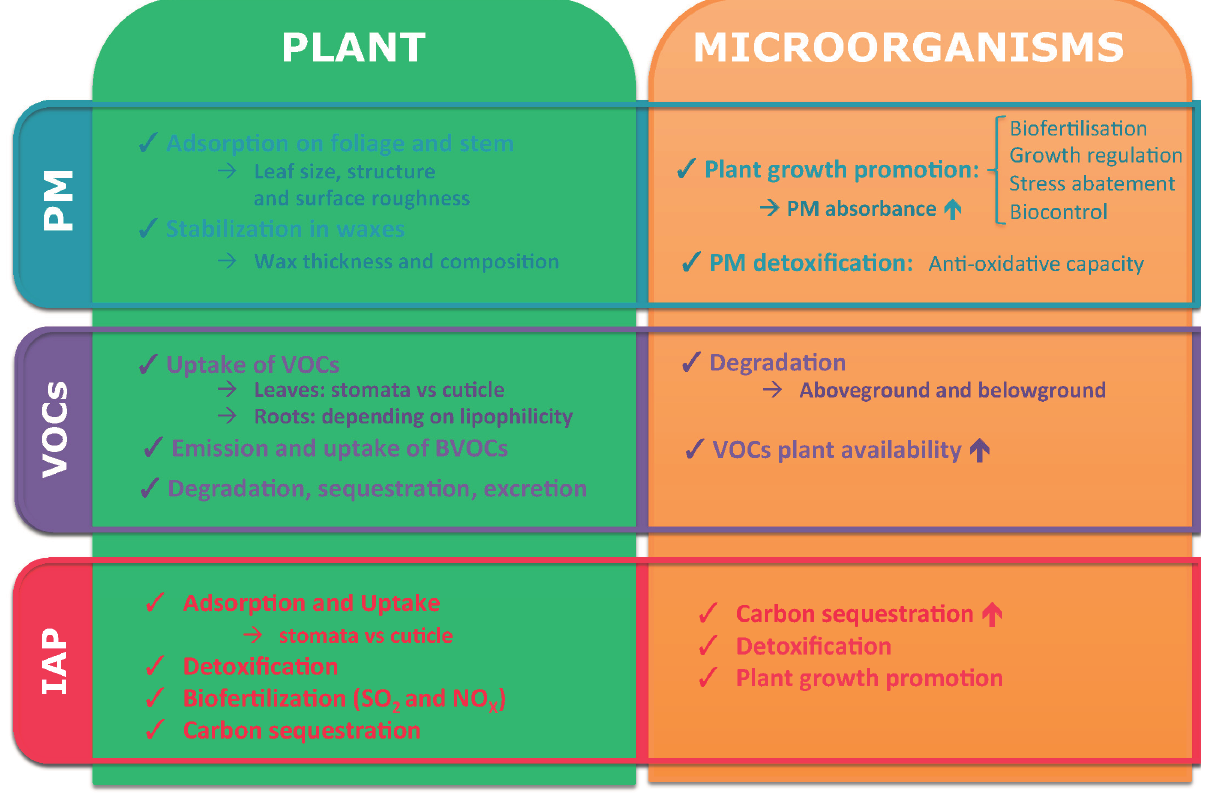
Figure 2. A concise overview of the specific contributions of the plant and its microbiome to the phytoremediation of the different categories of air pollution (increasing effects are indicated with 